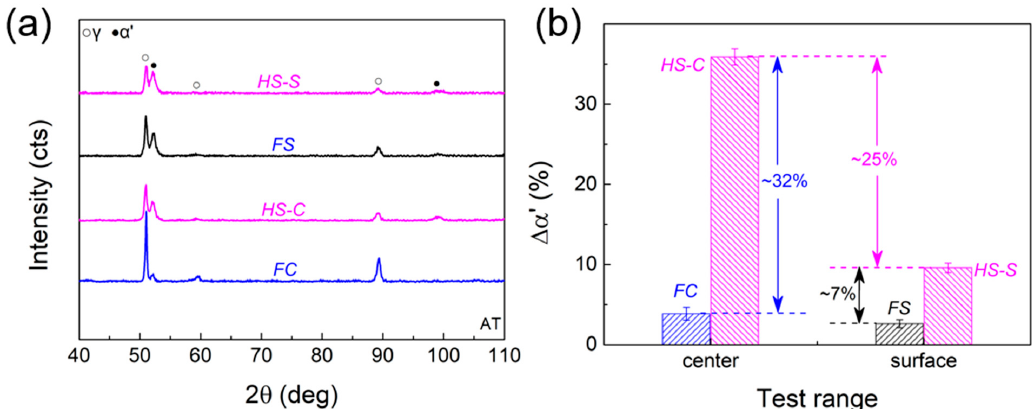
Figure 8. Phase content in different samples before and after tension. ( a ) XRD pattern of the sample after tensile deformation; ( b ) change in martensite content of the sample before and after tensile deformation.